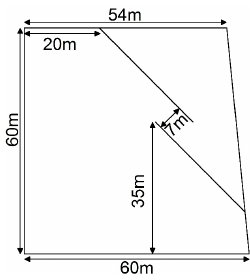
Figure 12. The section of the rock slope with parallel fractures and its size.